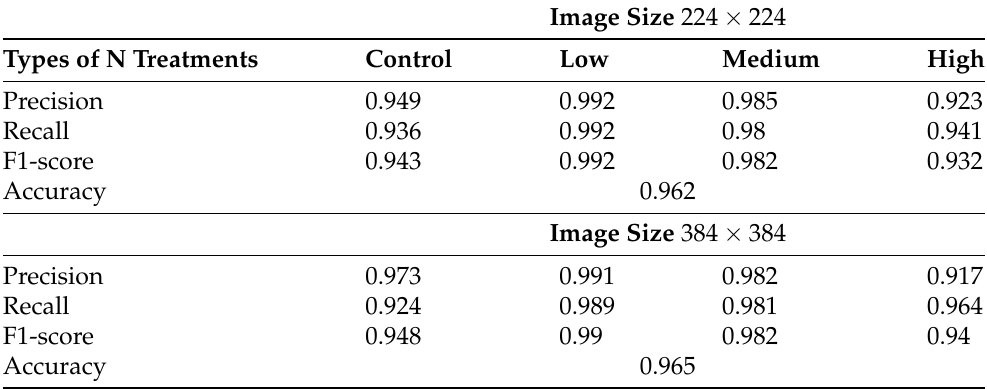
Table 4. The proposed model performance comparison with different input sizes under four N treatments.